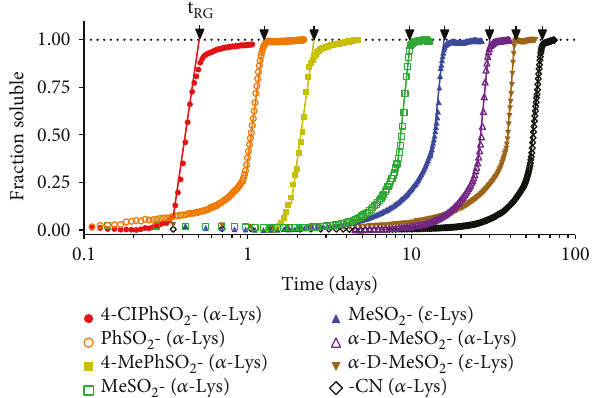
Figure 3: Formation of Tetra-PEG hydrogels with cleavable crosslinks connected to the α - or ε -amine of a lysine residue that forms part of the crosslink. The R groups in hydrogels 7 and 8 show the position where a cleavable linker can be attached to tether a releasable drug or, in the case of this work, where fl uorescein has been attached to facilitate detection of gel components by fl uorescence upon gel degradation.